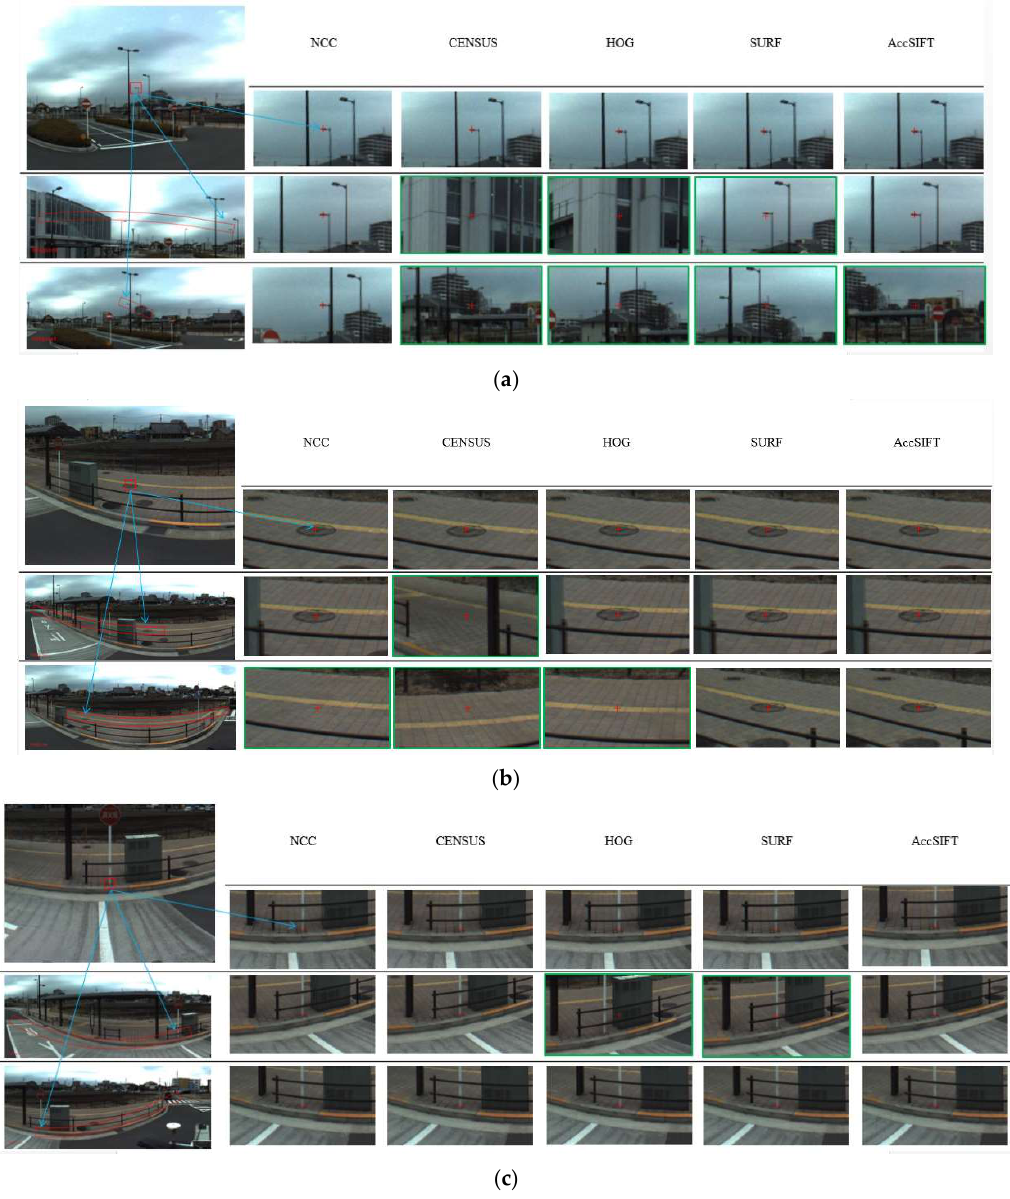
Figure10. Performances of template matching with different descriptors on the Kashiwa data. From left to right: reference image and the two adjacent search image, the results of the NCC, CENSUS, HOG, SURF and AccSIFT descriptors respectively.